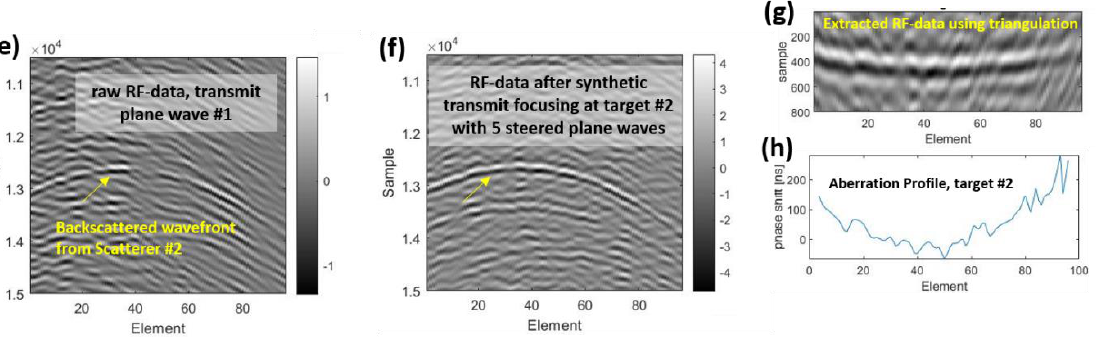
Figure 6 . Estimation of the aberration profile with the numerical dataset generated with the flat bone model and a heterogeneous background. The wavefront backscattered from ( a ) scatterer #1 and ( e ) scatterer #2; a tilted plane wave (by 7.5 degrees in cutaneous tissue) was used for excitation. The numerical wavefront backscattered by ( b ) scatterer #1 and ( f ) scatterer #2 after synthetic transmit focusing on the locations of scatterer #1 and #2, respectively, by coherent compounding of the RF data generated by 5 tilted plane waves (from −15 to 15 degree in cutaneous tissue). ( c , g ) The extracted wavefront using triangulation for scatterer ( c ) #1 and ( g ) #2. The estimated phase shift (aberration profile) in nanoseconds for scatterer ( d ) #1 and ( h ) #2.